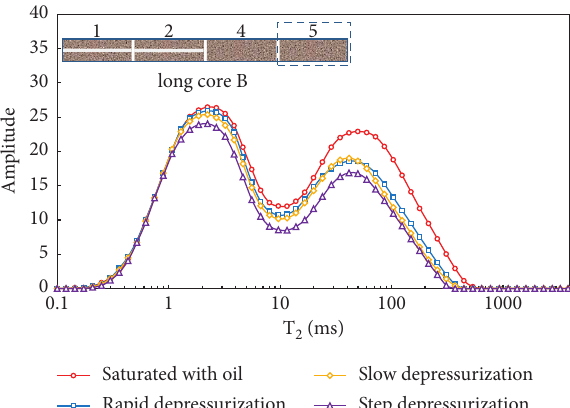
Figure 17: The microscopic remaining oil distribution of matrix core #5 after huff-and-puff tests with different depressurization method. Table 6: The oil recovery factor of different pores after huff-and-puff tests with different depressurization method. Pore types